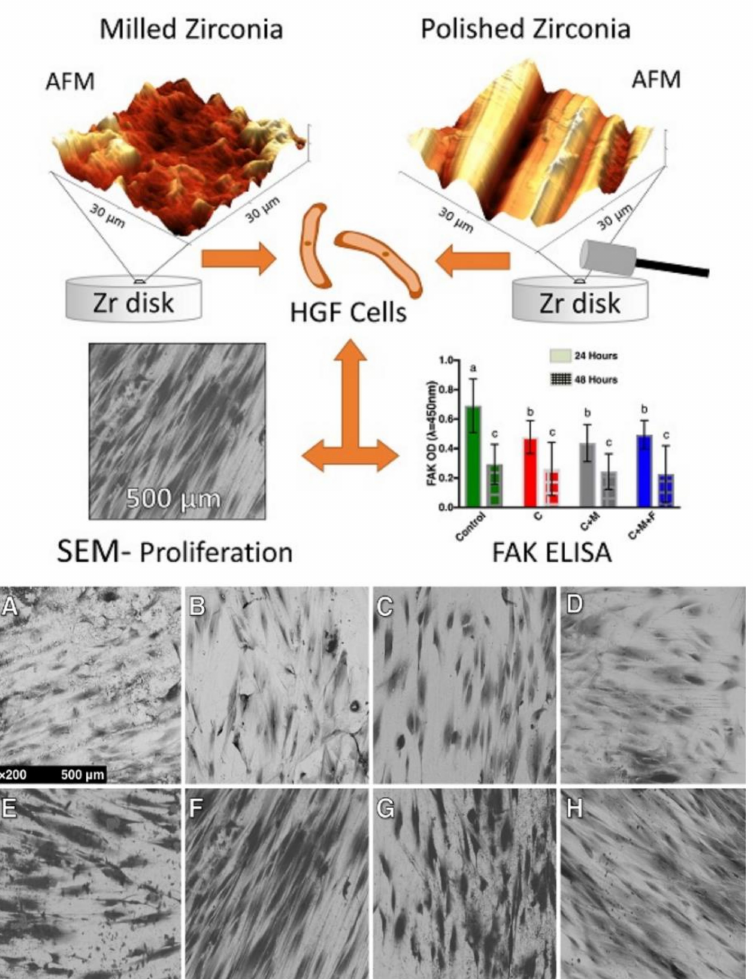
Figure 4. SEM micrographs demonstrating the different behavior and alignment of human gingival fibroblasts on different ZrO 2 -modified surfaces developed for implant abutments submitted to three different polishing protocols under a 24-h culture ( A – D ) and 48-h culture ( E – H ). The more polished surfaces showed greater cell counts ( B – D , F – H ) revealing an influence of polishing in the proliferation of this cell at 24 h and 48 h. Letters (a,b,c) represent statistical significance between the groups. Reprinted with permission under Creative Commons Attribution 4.0 International License, reference